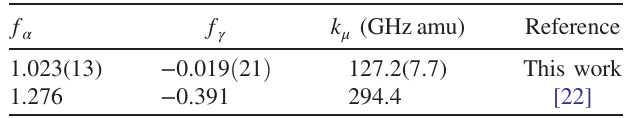
TABLE IV. Best-fit parameters of 3D King plots shown in Fig. 7. The error of each fit parameter is evaluated as 1 σ . The results are compared with the theoretical results Ref. [22] under the assumption that the QFS is eliminated by the construction of the 3D King